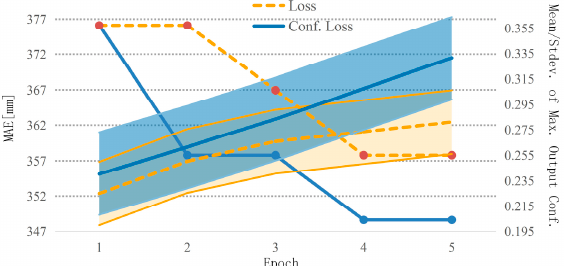
Figure 8. The impact of the proposed loss on con fi dence levels. Orange represents the loss function without con fi dence guidance, and blue represents the loss function with con fi dence guidance. The right axis represents the mean and standard deviation of maximum output con fi dence value over all images, while the left axis has the MAE in millimeters. When using a loss with only a data term, output con fi dence levels are lower, while our proposed loss achieves monotonically increasing con fi dence levels as well as a lower MAE. Note that the shaded area represents the standard deviation.